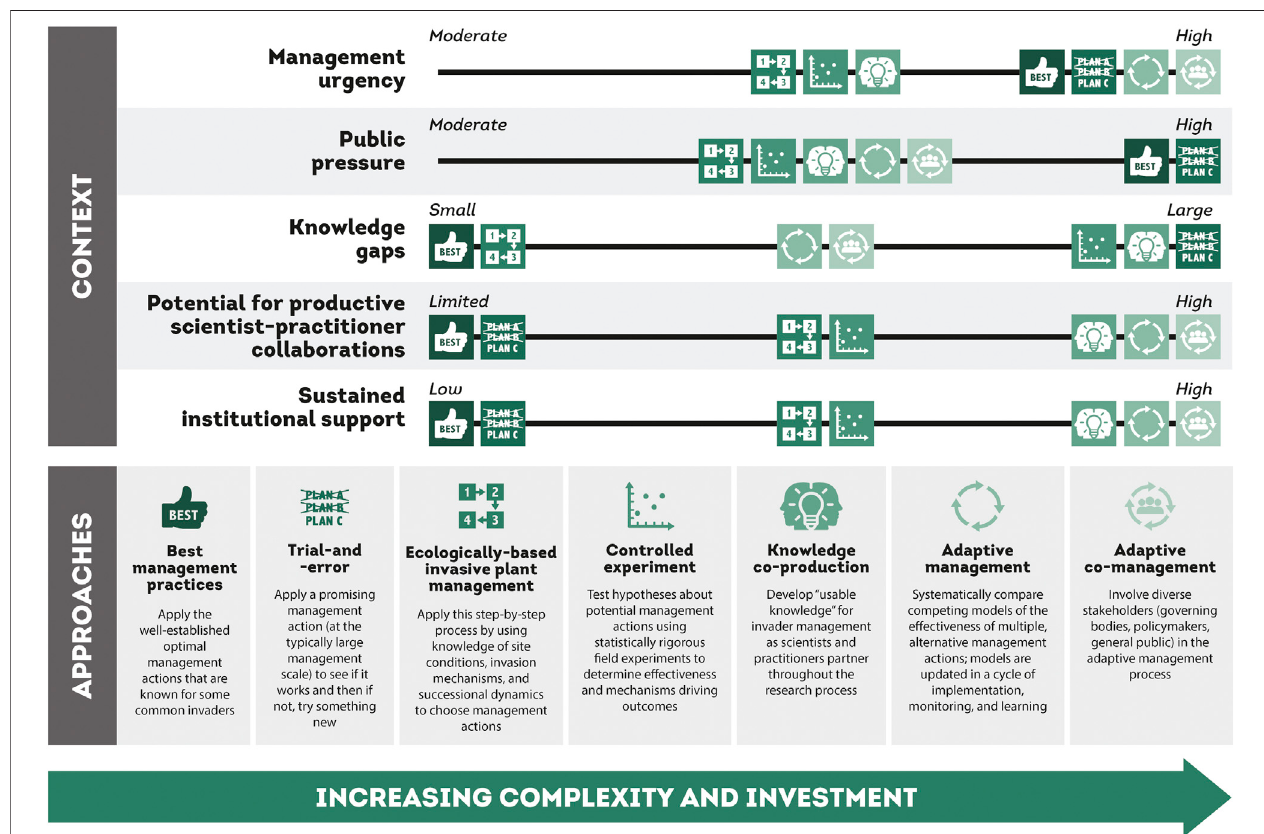
FIGURE2| Severalstructuredapproachescanbeemployedtoaddresswetlandinvasions.Thesestructuredapproachesre fl ectthemyriadwaysthatscienceand management intersect along a continuum of complexity and investment. The choice of which structured approach is appropriate for a given situation depends on context:theurgencyformanagement,theextentofpublicpressuretocontrolaninvader,howmuchisknownaboutaninvaderanditsmanagement( “ knowledgegaps ” ), thepotentialforproductivescientist-practitionercollaborations,andthelikelihoodforsustainedinstitutionalsupport.Managementurgencyishighwhenimpactsto valued resources such as areas for recreation, conservation, or other ecosystem services are known to be considerable. Public pressure is high when the invader is a high-pro fi le species or stakeholders are outspoken (both of which may be unrelated to risk). Knowledge gaps are large when invader mechanisms or